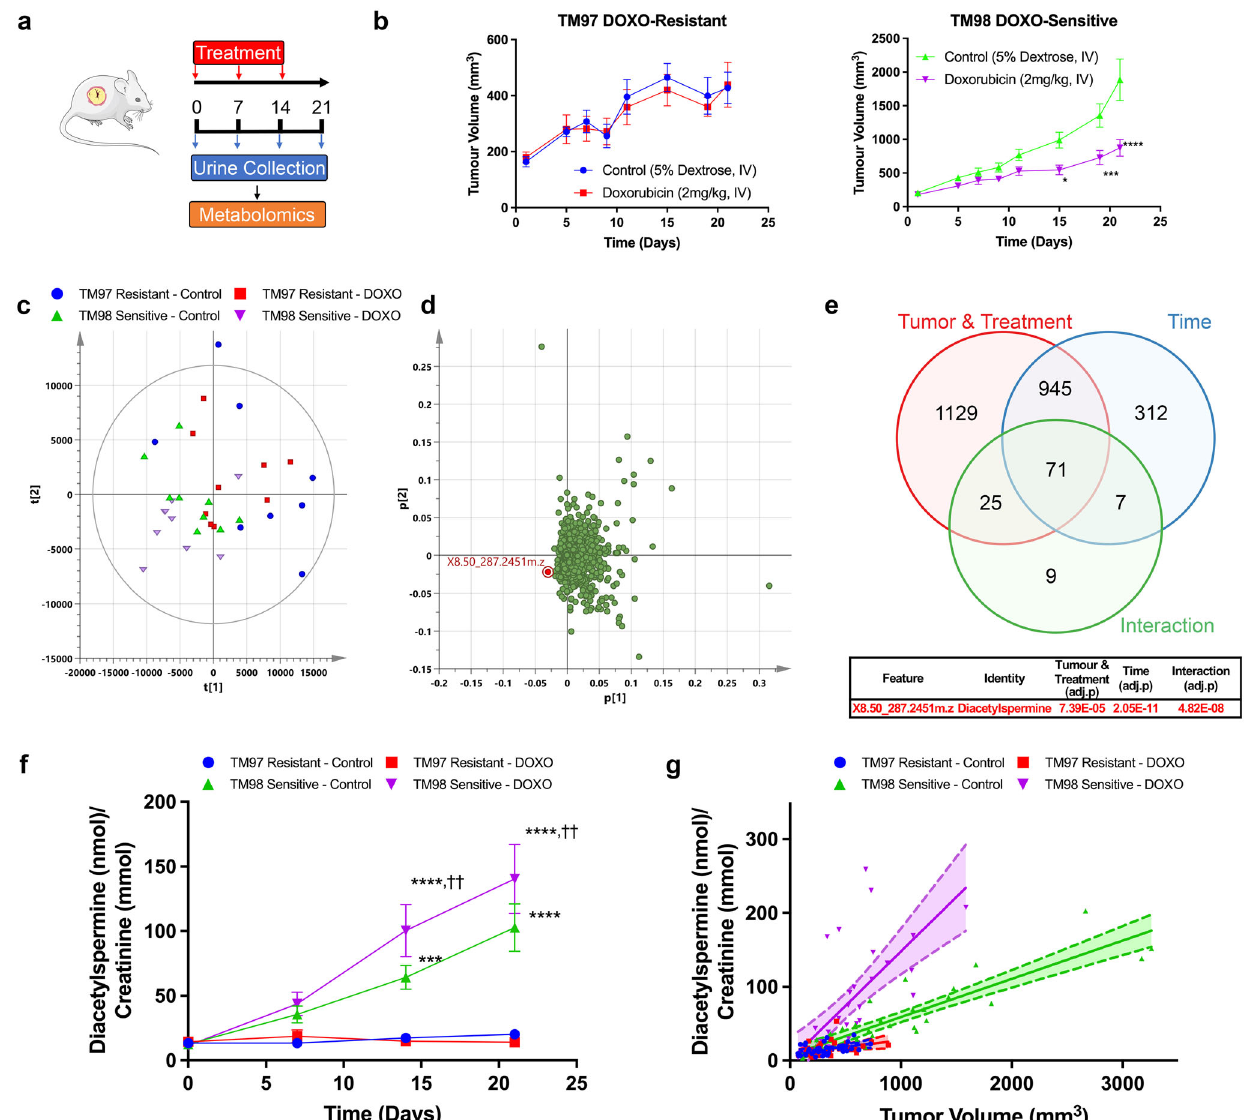
Fig. 1 Longitudinal urine metabolomics identi fi es diacetylspermine as a metabolic biomarker of doxorubicin effectiveness. a Experimental design for urine collection of TNBC-PDX TM97 and TM98 mice treated with vehicle (5% dextrose, IV) or doxorubicin (DOXO, 2 mg/kg, IV). b Tumor growth curves showing TM97 resistance and TM98 sensitivity to DOXO treatment. c , d Principal component analysis and loadings plot of untargeted urine metabolomics on day 21. e Venn diagram showing number of signi fi cantly altered features